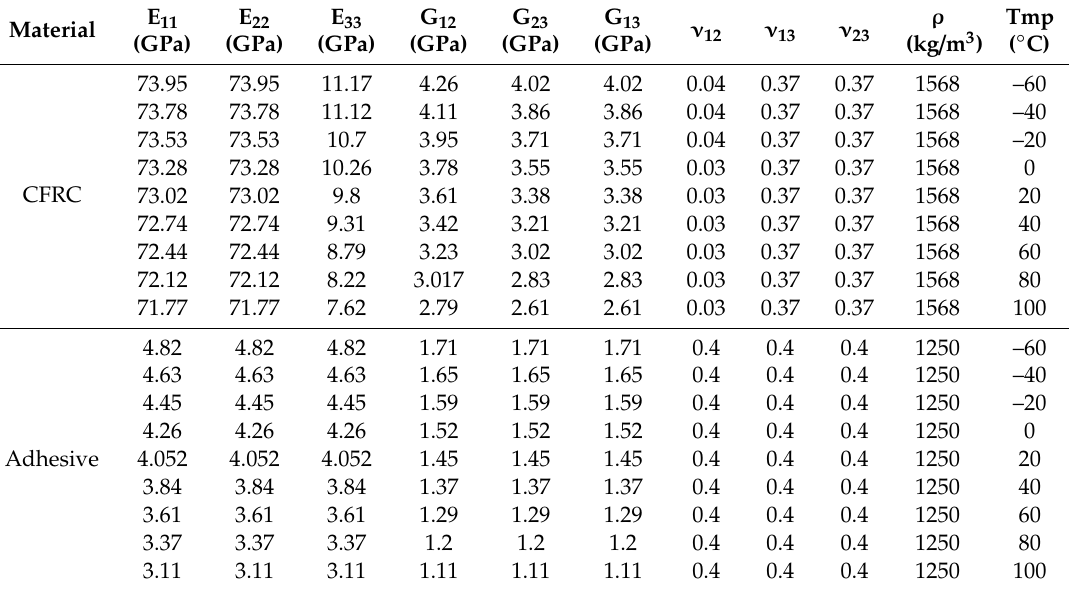
Table 2. Temperature-dependent material properties of the